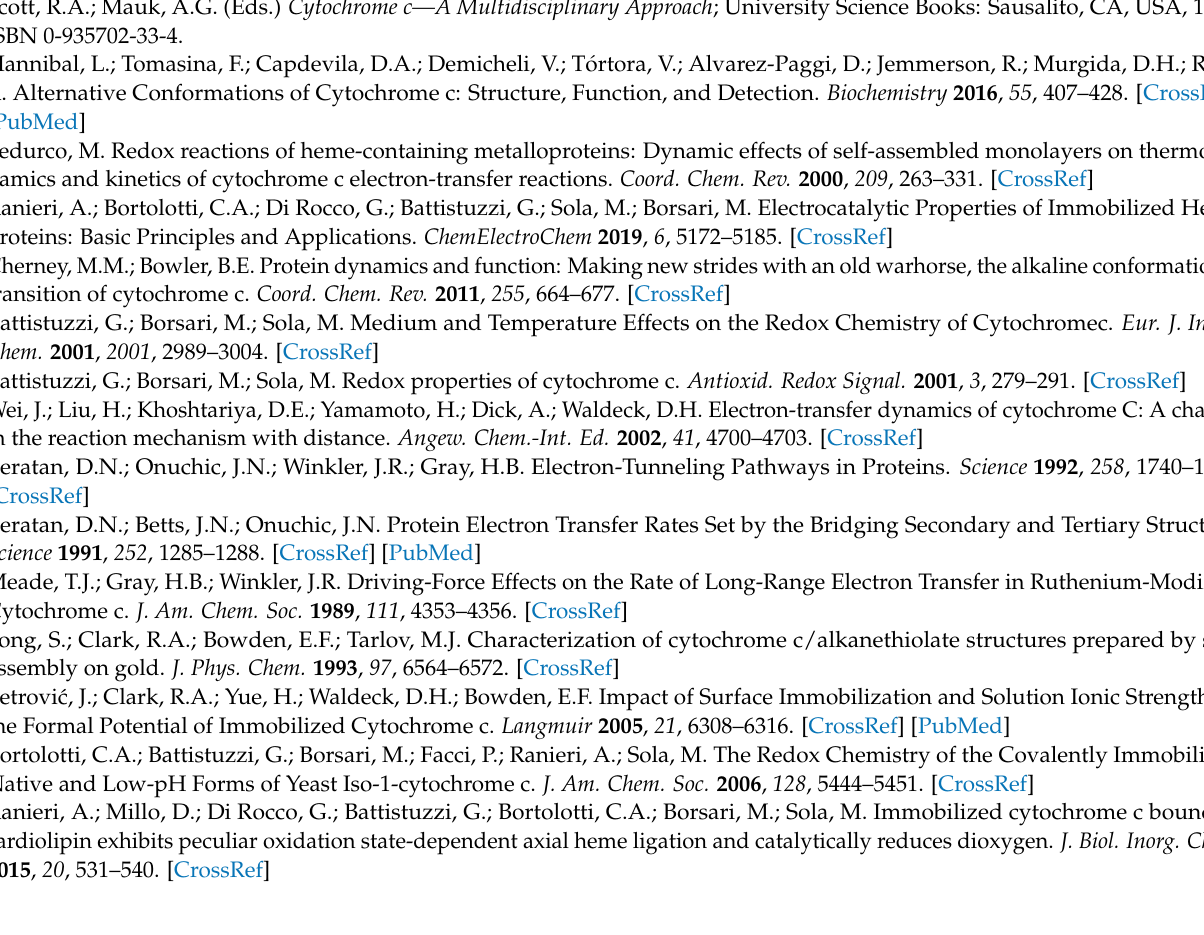
Figure S3: Square wave voltammograms of M80A cytc in 50% DMSO at 278K and